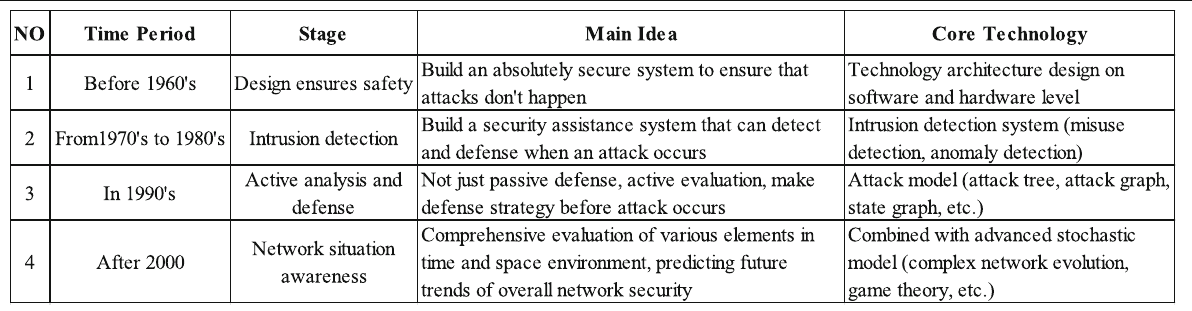
Table 1 Four main stages of network security